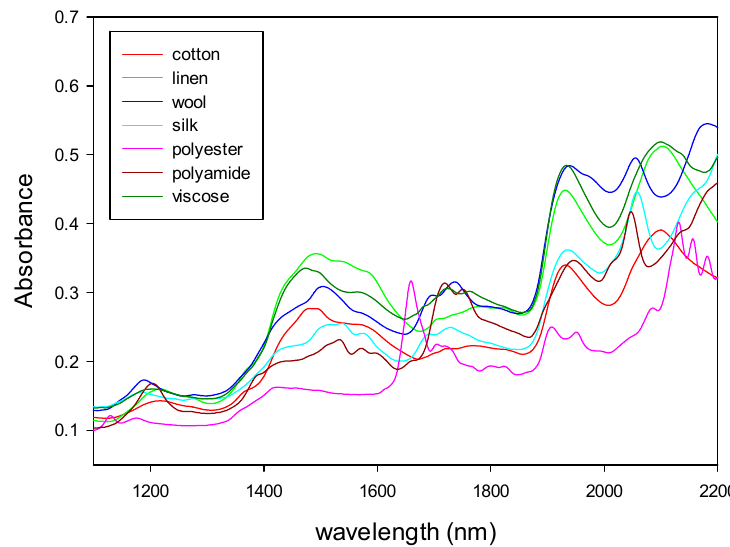
Figure 4. NIR spectra of natural and synthetic fibers.